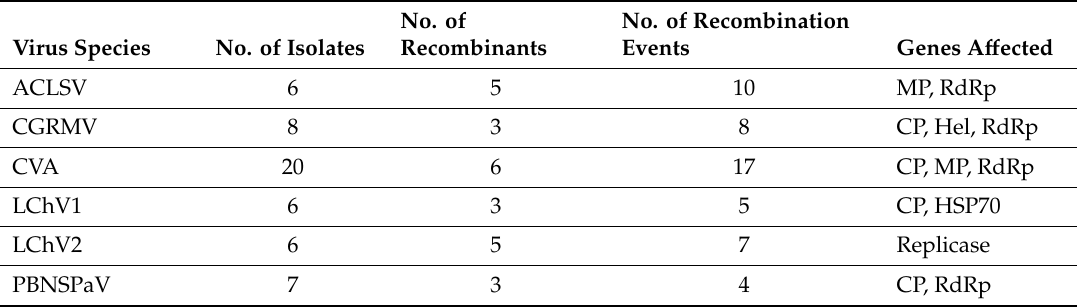
Table 6. The number of recombinants and recombination events identified using the RDP4 package within full genome sequences of Australian Apple chlorotic leaf spot virus (ACLSV), Cherry green ring mottle virus (CGRMV), Cherry virus A (CVA), Little cherry virus 1 (LChV1), Little cherry virus 2 (LChV2) and Plum bark necrosis stem pitting-associated virus (PBNSPaV) isolates are